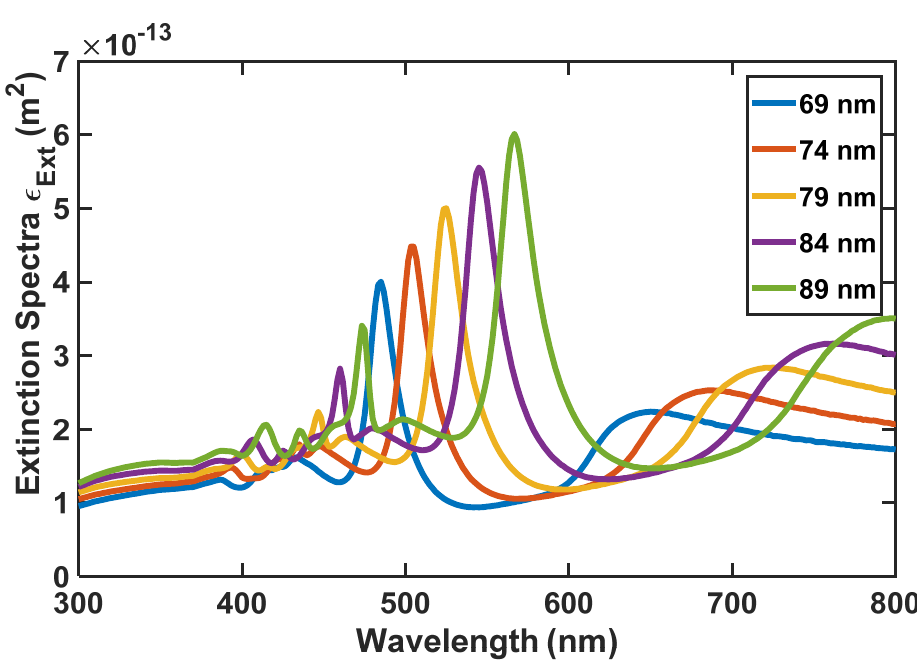
Figure 12. SiO 2 /Si nanoparticle’s extinction spectra for its different radii.